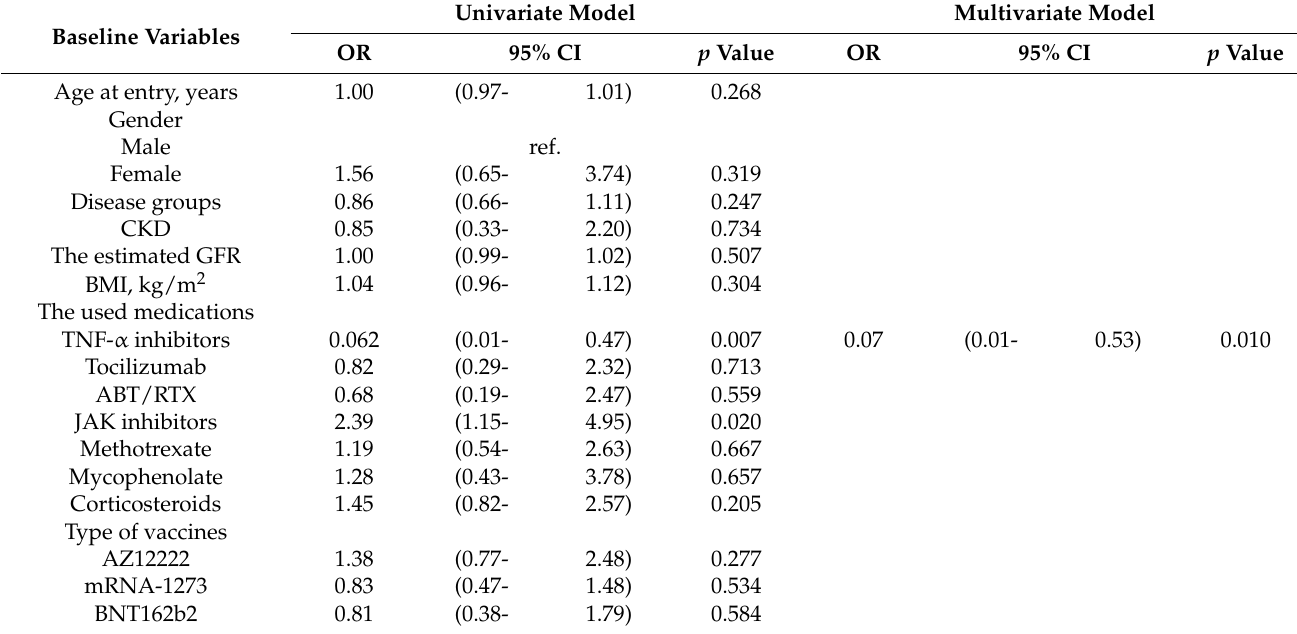
Table 4. Logistic regression analysis for predicting the occurrence of adverse